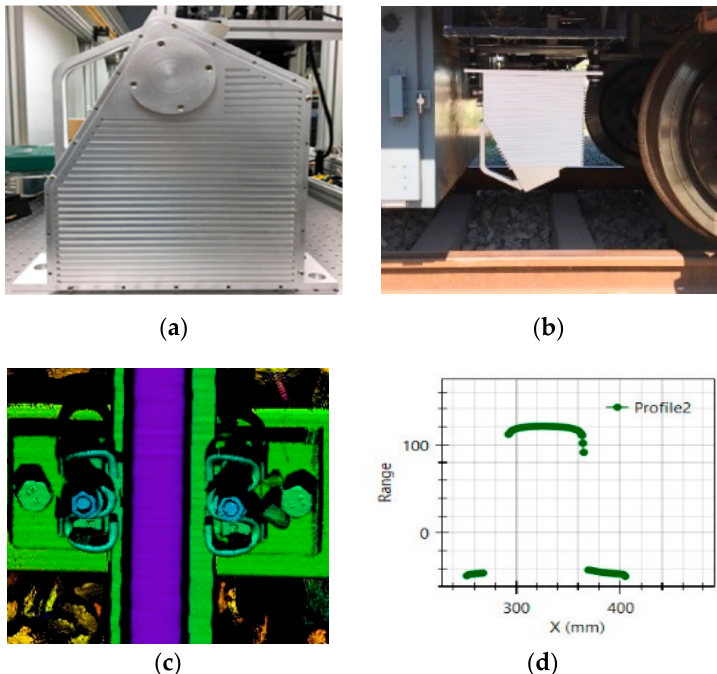
Figure 11. On-site dynamic test: (a) 3D measurement components; (b) on-site installation; (c) rail track